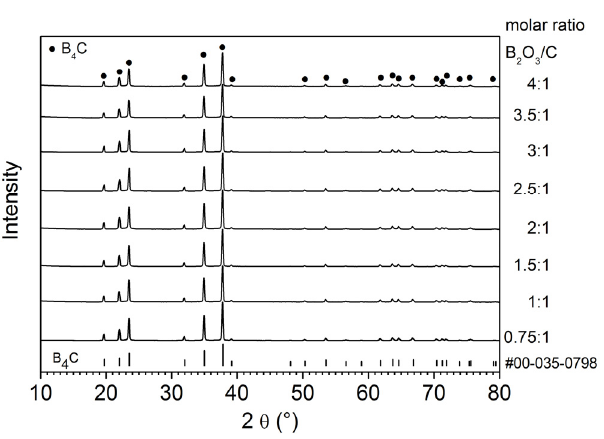
Figure 5. XRD patterns of products synthesized at 1900 °C for 20 min using mixtures with a molar ratio of B 2 O 3 /C from 0.75–4:1.